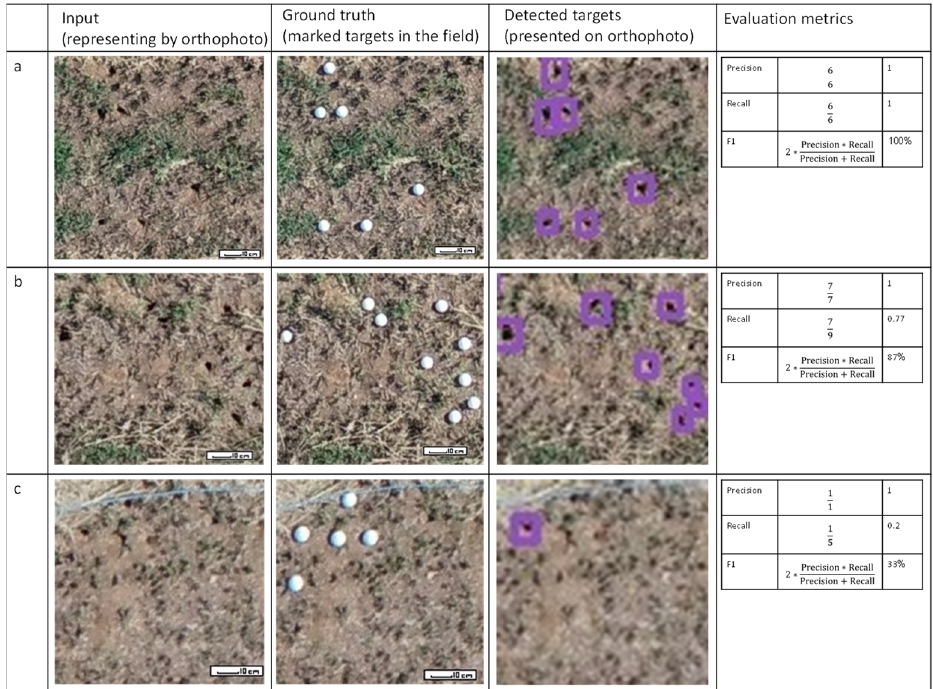
Figure 7. Selected examples of detection level for the external test sites, ( a ) the best; ( b ) the moderate; and ( c ) the worst, results of the model.